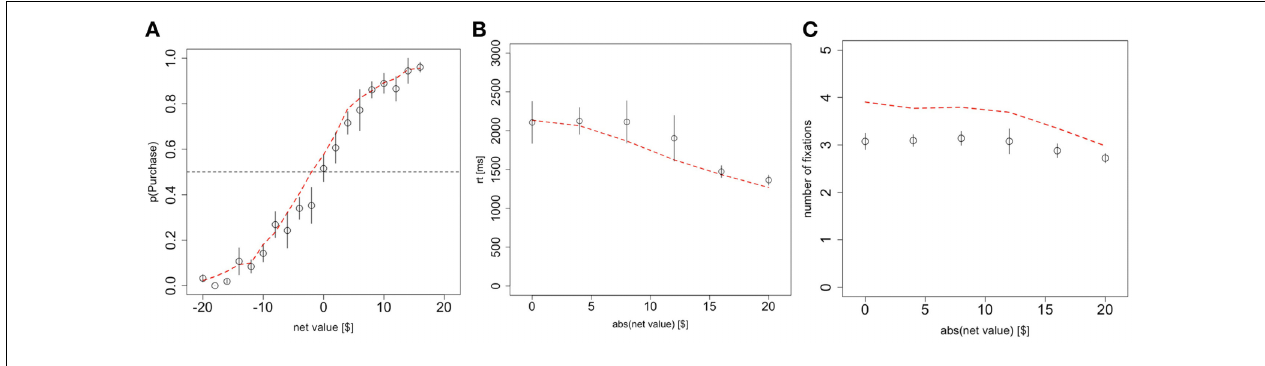
the net value. Black circles indicate data from the odd-numbered trials of the subject data, and red dashed lines indicate the simulated data from the aDDM. Bars are standard error bars, clustered by